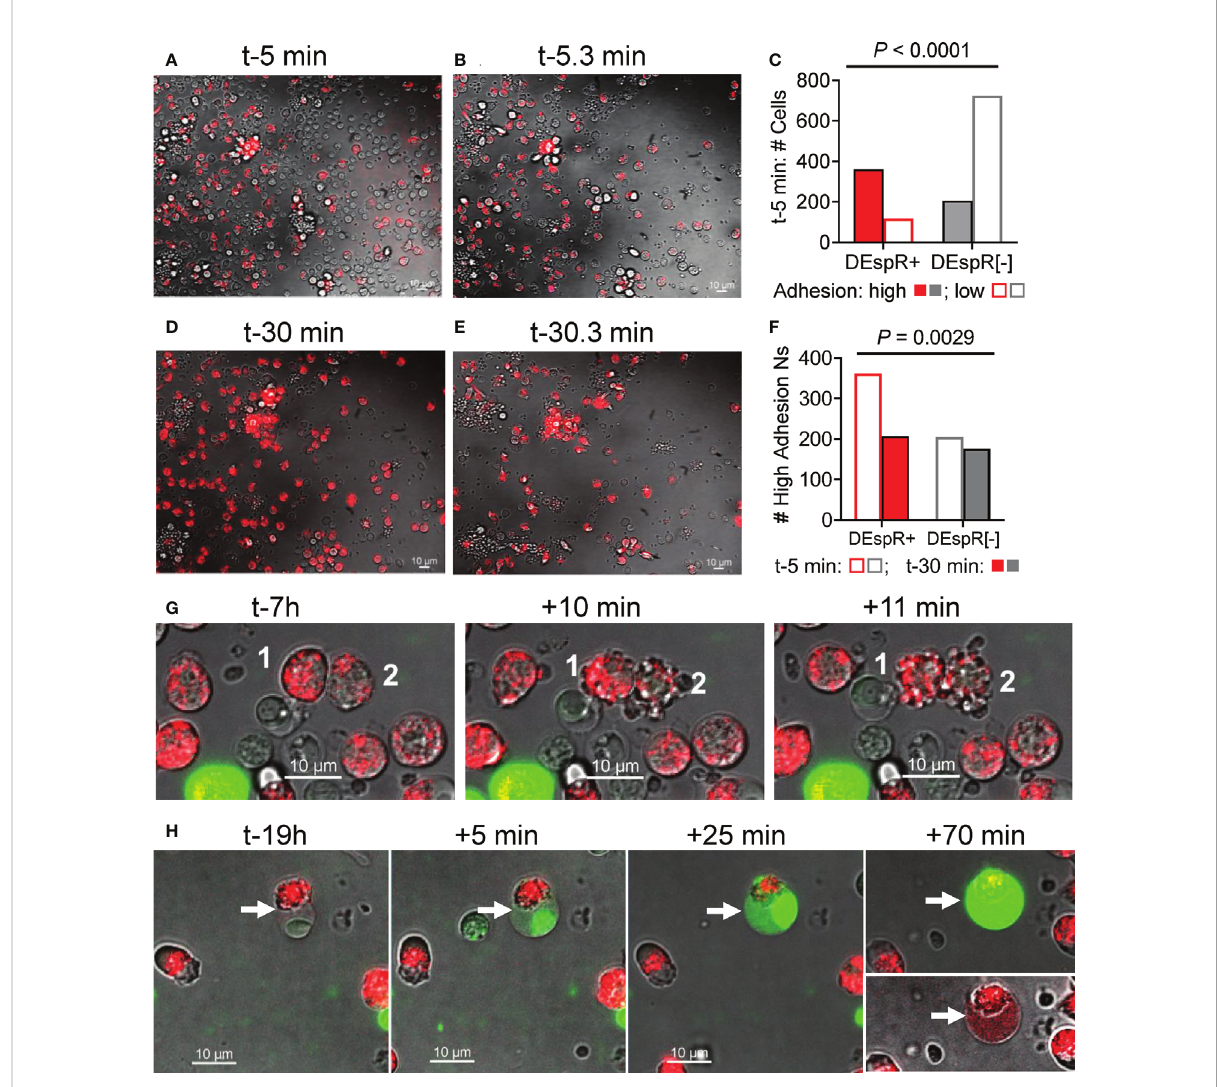
FIGURE 3 Analysis of neutrophil adhesion during live cell imaging. (A) Representative live-cell imaging snapshot showing DEspR+ neutrophils (with bound AF568-hu6g8) and unbound DEspR[-] neutrophils/leukocytes adhered onto the micro fl uidic-chip channels at t-5 min from seeding, before media change. (B) Representative live-cell imaging snapshot immediately after media change t-5.3 min detecting high-adhesion leukocytes (adhesion resists media change) and concomitant loss of leukocytes (low adhesion). (C) Graph showing that majority of high-adhesion neutrophils (solid bars) are DEspR+ (red); majority of low adhesion cells (open bars) are DEspR[-] (grey), P < 0.0001, Fisher ’ s Exact test. (D) Representative live-cell imaging snapshot at t-30 min with internalized AF568-anti-DEspR hu6g8 moving towards focal z-plane preset at mid- nuclear level during live-cell imaging. (E) Representative snap shot of high-adhesion cells after media change among DEspR+ and DEspR [-] neutrophils/leukocytes, and concomitant loss of low-adhesion cells. (F) Bar graph showing loss of DEspR+ neutrophils at ~t-30.3 min from seeding and after media change. Fisher ’ s exact test P value = 0.0029. Bar = 10 m m. (G) Representative serial live cell imaging snapshots at t-7h showing DEspR+ neutrophils fl uorescing with internalized AF568-anti-DEspR hu6g8 and exhibiting nuclear and cellular budding characteristic of apoptosis within 10min from start of cell budding. (H) Representative serial live cell imaging snapshots at t-19h showing late apoptosis characteristics with nuclear condensation, and increasing cell swelling and permeability marked by increased staining with impermeant Sytox Green DNA-stain over 70